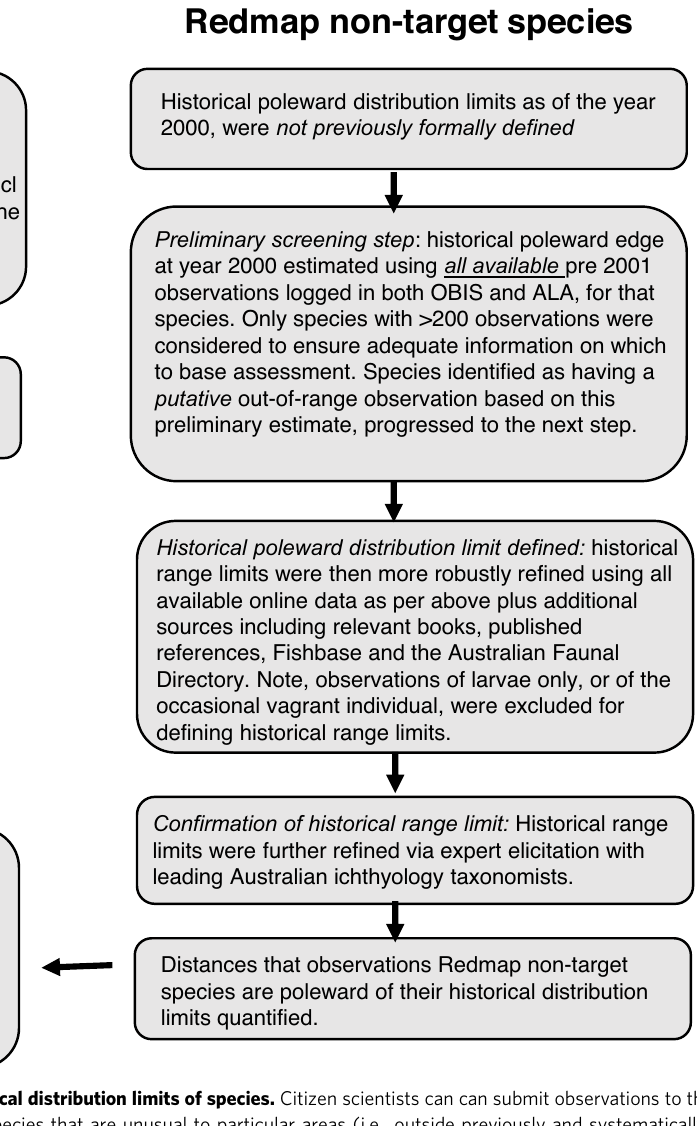
Fig. 2 Flow diagram of the steps taken in the estimation of historical distribution limits of species. Citizen scientists can can submit observations to the Redmap program of species from region-speci fi c lists of ‘ target ’ species that are unusual to particular areas (i.e., outside previously and systematically determined expected historical distribution limits) as well as observations of any species they consider unusual for an area (non-target